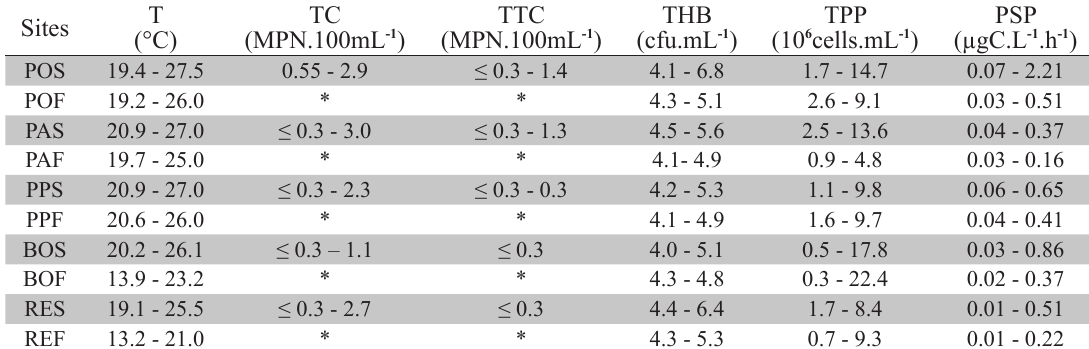
Range of temperature and microbiological variables measured in the different